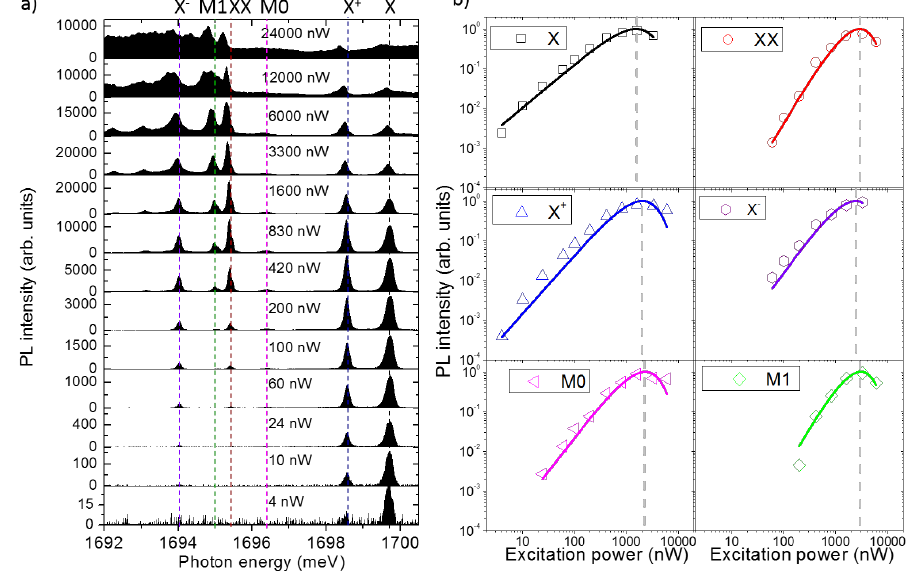
Figure 3. ( a ) PL spectra from low to high excitation power for the same QD shown in Figure 2. The incident power is highlighted on each panel. The vertical dashed lines act as guides for the eyes. ( b ) Evolution of the six main PL lines as a function of the incident excitation power. The PL intensity has been normalized to the maximum for each component. Each panel refers to a specific exciton complex recombination as highlighted by the corresponding labels. Symbols are the experimental data whereas lines are Poissonian